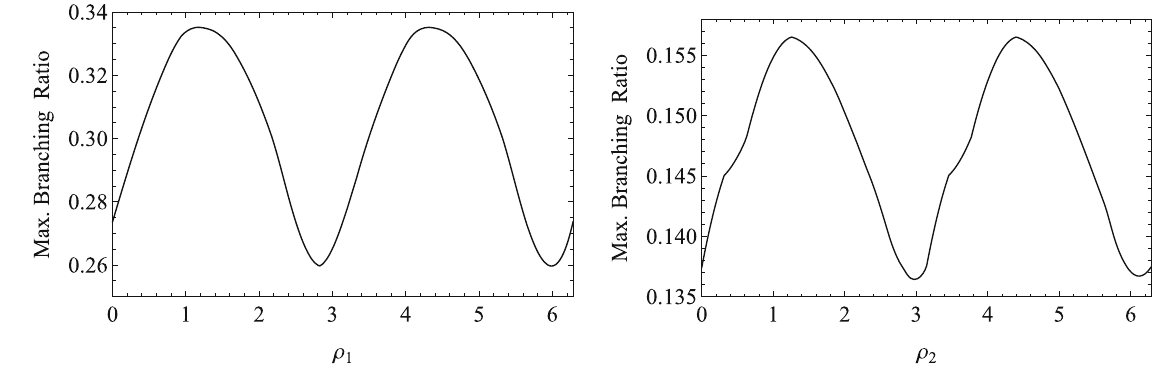
branching ratio obtained after performing a parameter scan for rest of (cid:6) 3 ( N i → i the free parameters, θ 1 , 2 , 3 , Y , and ρ 2 (ρ 1 ) . From the figure we read the m N m i = 1 BR ρ maximum value to be 0 . 337 (0 . 157) for the NH (IH) case 1 ( 2 ) for the